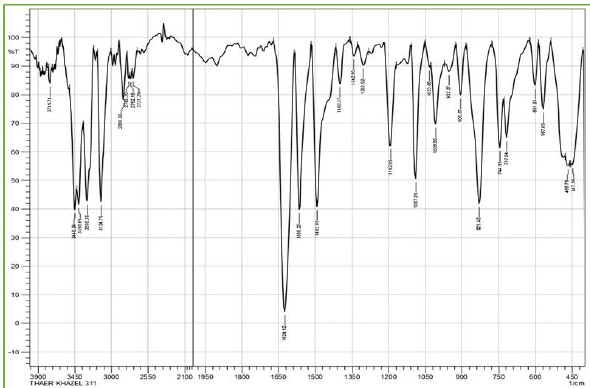
Fig. 1. IR spectrum of 2-Amino 4-(4-Chloro-phenyl)thiazole ligand